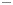
Effect of ET-1 and levosimendan on pulmonary haemodynamics in the IPL.A) Pulmonary arterial pressure (PPA). B) Left atrial pressure (PLA). C) Pulmonary vascular resistance (PVR). D) Pulmonary capillary pressure (Pcap). E) Precapillary resistance (Rpre). F) Postcapillary resistance (Rpost). For all: ▔ control (n = 8); ▔ levosimendan (n = 8); ● 15 nM ET-1 (n = 7); ● 15 nM ET-1 / 10 μM levosimendan (n = 8). A-F: Statistics was performed by a linear mixed model analysis (LMM). P<0.05 are considered as significant: * p<0.05, ** p<0.01 and *** p<0.001.